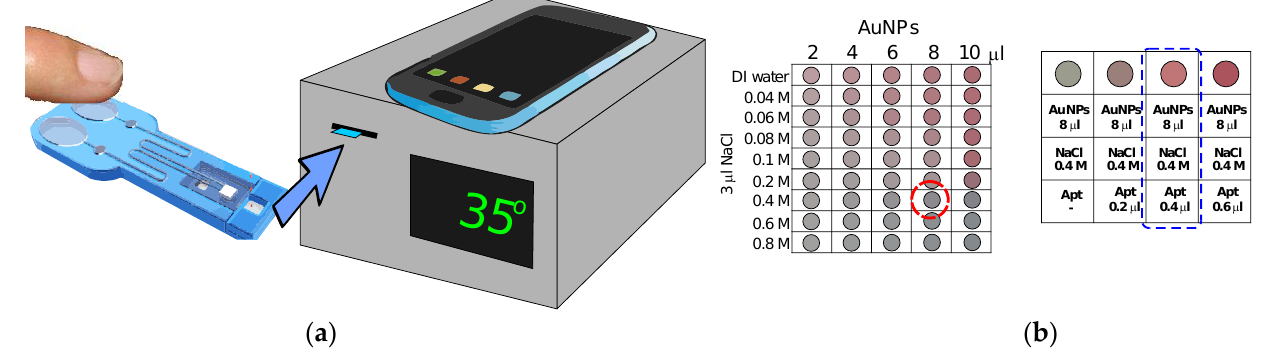
Figure 34. ( a ) The example of aptamer biochip to K + detection and the dedicated device for operation, ( b ) Reaction color for different volumes of AuNPs and concentrations of 3 mLNaCl together with reaction color for 8 mL AuNPs, 3 mL NaCl (0.4 M) and different volumes of aptamers [121].